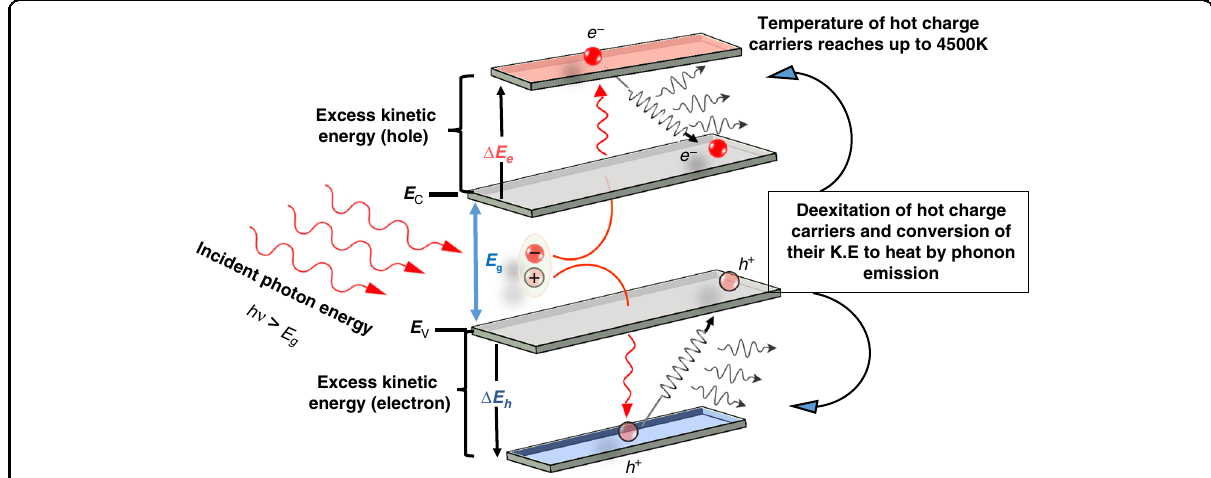
Fig. 3 Absorption of an incident photon carrying energy higher than the bandgap energy ( E g ) of the photoabsorber. The excitation of an electron leaves behind a positive charge (hole). Excited electrons and holes are collectively called HC, whose excess energy is Δ E e and Δ E h for hot electrons and hot holes, respectively. Upon de-excitation, the excess energy is converted to heat by the emission of